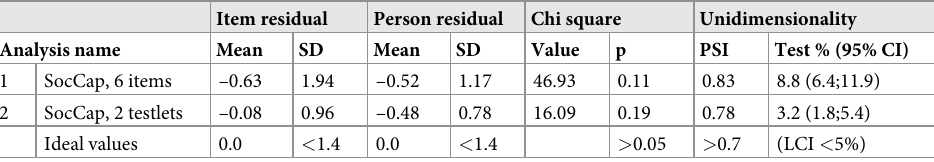
Table 4. Fit to the Rasch model, summary fit statistics, n = 422.